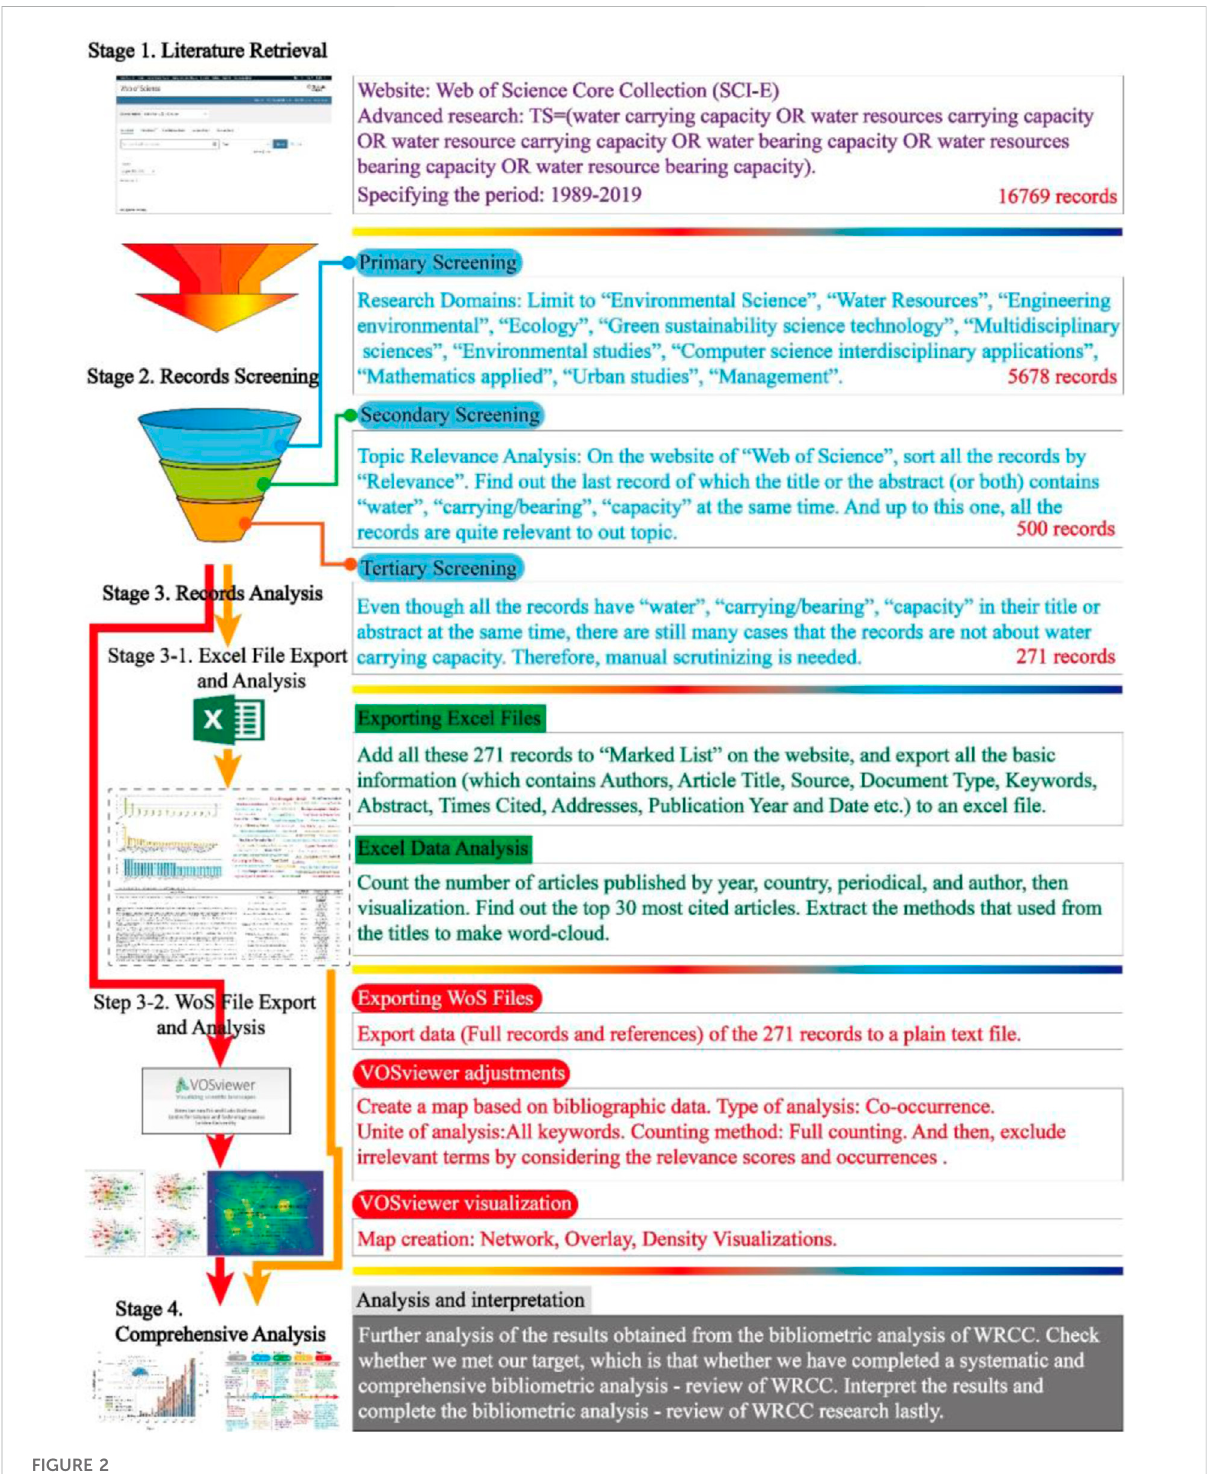
FIGURE 2 Details of application process of four-stage bibliometric analysis